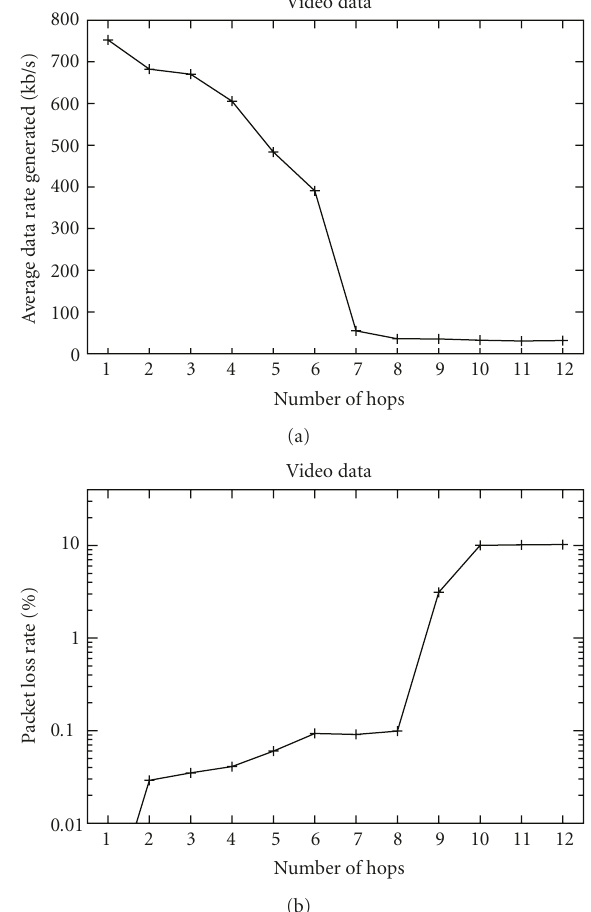
Figure 21: Average data rate generated (a) and packet loss ratio (b) for di ff erent numbers of